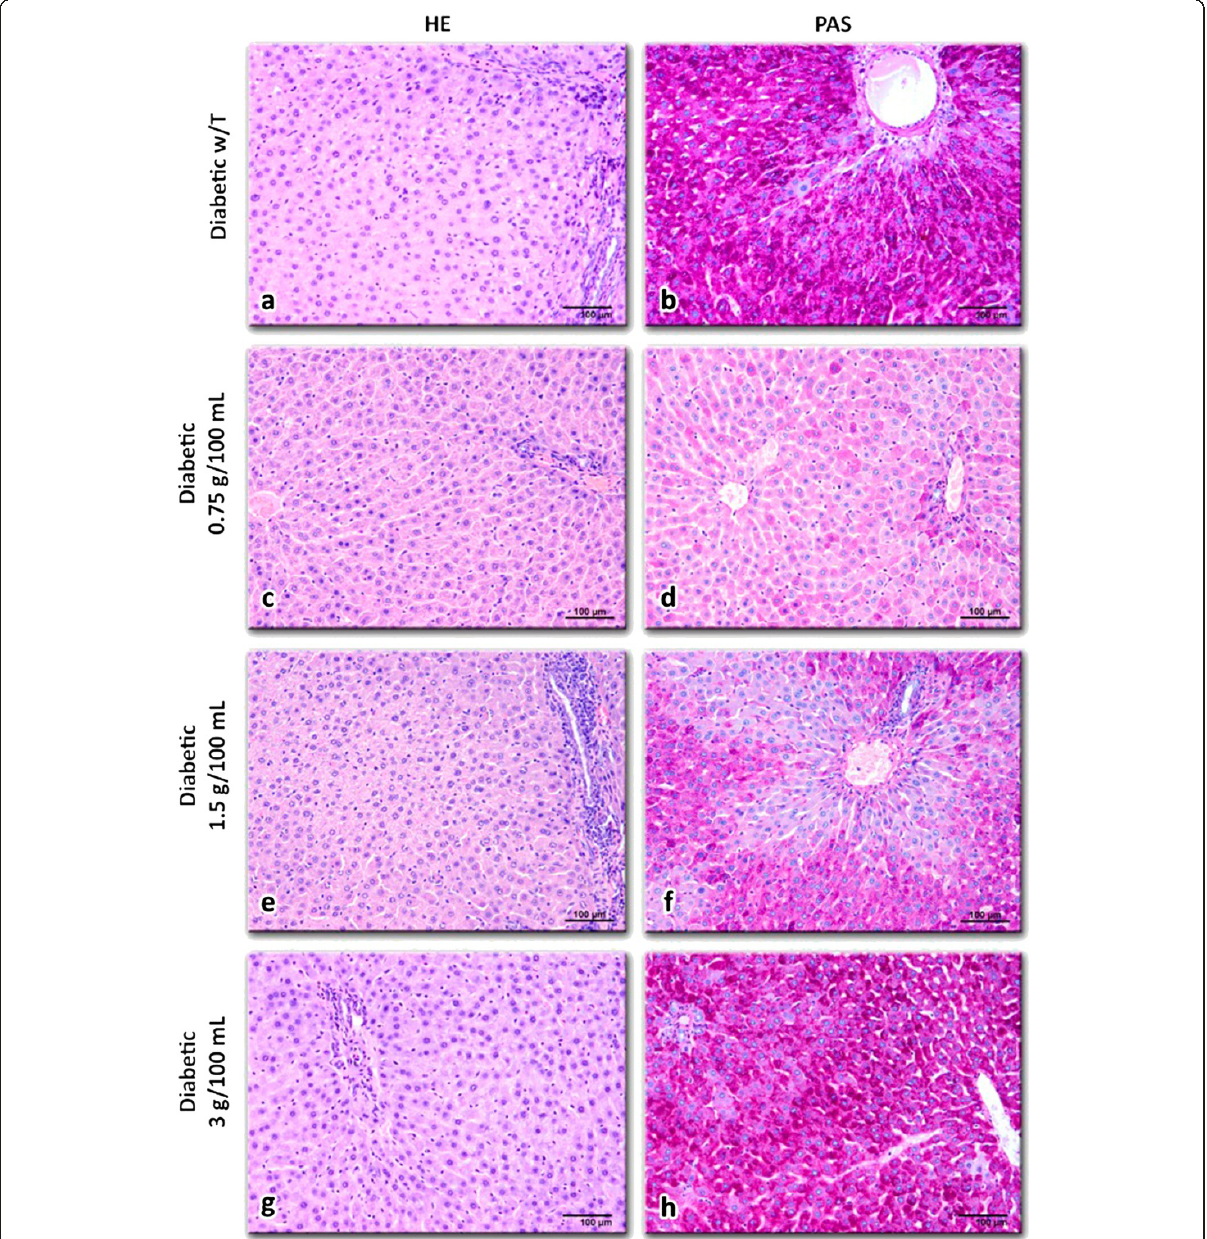
Figure 3 Liver slices from diabetic rats without treatment (a, b) and with C. papaya aqueous extract treatments: 0.75 g/100 mL (c, d), 1.5 g/100 mL (e, f) or 3 g/100 mL (g, h). It is noteworthy that in ( d ) and ( f ) the glycogen content in hepatocytes was reduced as compared with ( b ). h ) Similar tissue aspect than in ( b ). Hematoxilin-eosin ( a, c, e, g ) and PAS ( b, d, f, h ) staining,